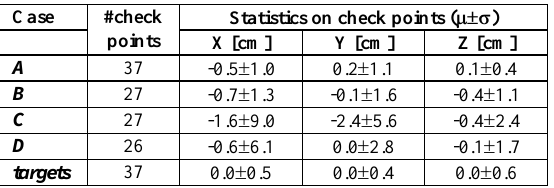
Table 5. Results of the registration of 3 scans (1,22,23) based on ‘pano-I’ images. Case